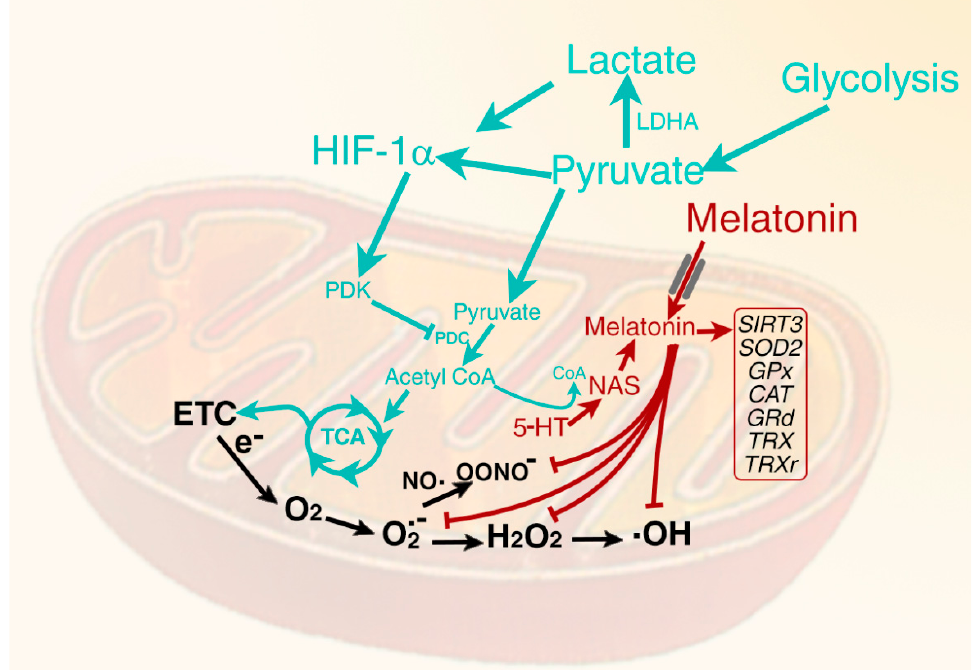
Figure 4. Melatonin is synthesized in mitochondria and can be taken up from the systemic circula- tion by these organelles. In healthy cells, mitochondrial melatonin is an effective direct scavenger of ROS and RNS (shown by red lines), which are generated normally but also in excess when the elec- tron transport chain (ETC) is faulty. Additionally, melatonin indirectly aids in maintaining redox homeostasis by upregulating the deacetylase, SIRT3, and a series of antioxidant enzymes (boxed). This figure also illustrates the necessity of acetyl-CoA for mitochondrial melatonin production; mel- atonin synthesis ceases in the absence of this co-substrate. The absence of acetyl-CoA is a conse- quence of the inhibition of the pyruvate-to-acetyl-CoA transformation due to the suppression of pyruvate dehydrogenase complex (PDC; PDH is one component of this complex), which is under tight control, and inhibited by pyruvate dehydrogenase kinase (PDK). The upregulation of PDK is often a result of the stabilization of cytosolic hypoxia-inducible factor-1 α (HIF-1 α ), an oxygen-sens- ing transcription factor. In normoxic healthy cells, HIF-1 α is ubiquitinated and undergoes pro- teasomal degradation. During hypoxia, HIF-1 α is stabilized, leading to the upregulation of PDK and the inhibition of PDH, resulting in mitochondrial melatonin synthesis inhibition. Warburg metabo- lism (aerobic glycolysis), however, occurs under normoxic conditions; in this case, the excess of py- ruvate and lactate in the cytosol presumably destabilizes HIF-1 α such that PDH is disinhibited. 5- HT = serotonin; CAT = catalase; CoA = coenzyme A; e − = electron; GPx = glutathione peroxidase; GRd = glutathione reductase; H 2 O 2 = hydrogen peroxide; LDHA = Lactate dehydrogenase-A; NAS = N-acetylserotonin; NO· = nitric oxide; ·OH = hydroxyl radical; ONOO − = peroxynitrite anion; PDH = pyruvate dehydrogenase; SOD2 = superoxide dismutase 2; TCA = tricarboxylic acid cycle; TRX = thioredoxin; TRXr = thioredoxin reductase.